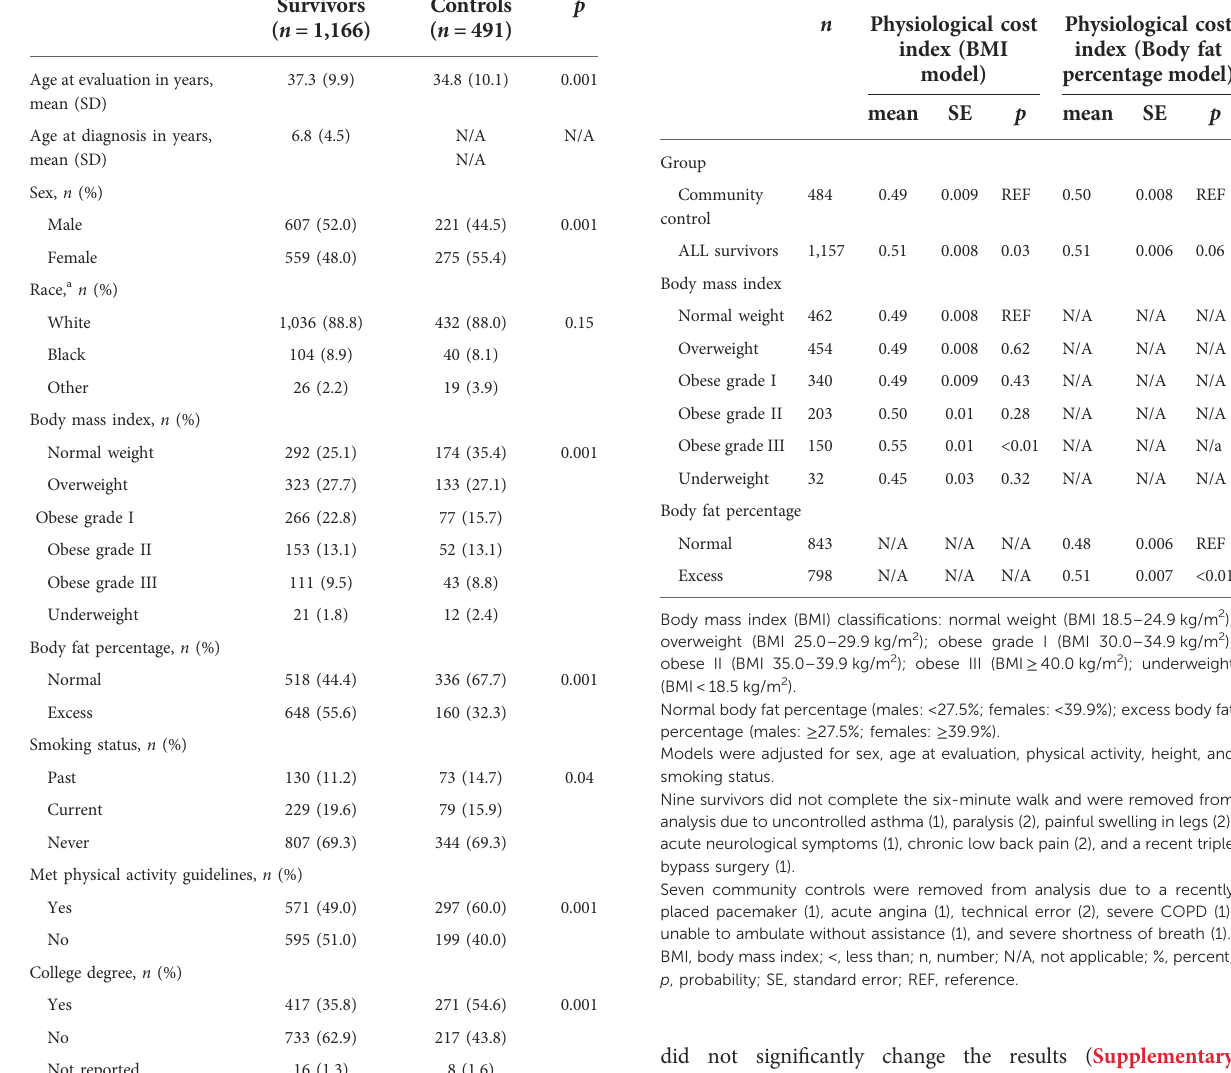
TABLE 2 Associations between physiological cost index and body mass index or body fat percentage in adult survivors of childhood acute lymphoblastic leukemia vs. community controls.